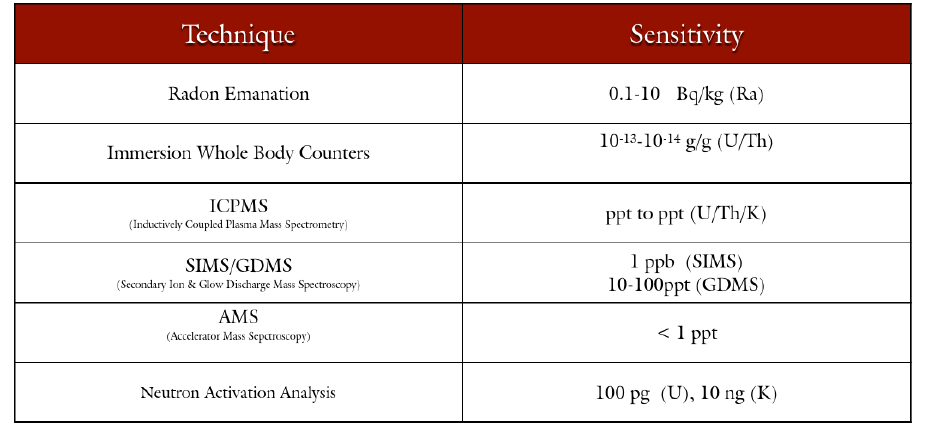
Figure 19: A comparison of material screening approaches and their current standard sensitivities.